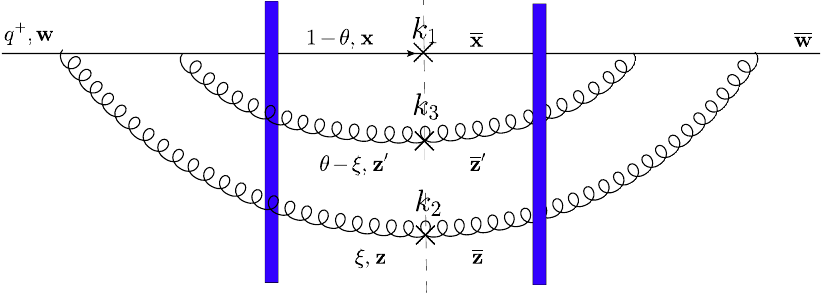
Figure 9 . A contribution to the qgg cross-section (3.39) which features final-state interactions in both the DA and the CCA; the respective colour structure is shown in eq. (3.43). There is a similar diagram in which the momenta k and k of the final gluons are exchanged with each 2 3